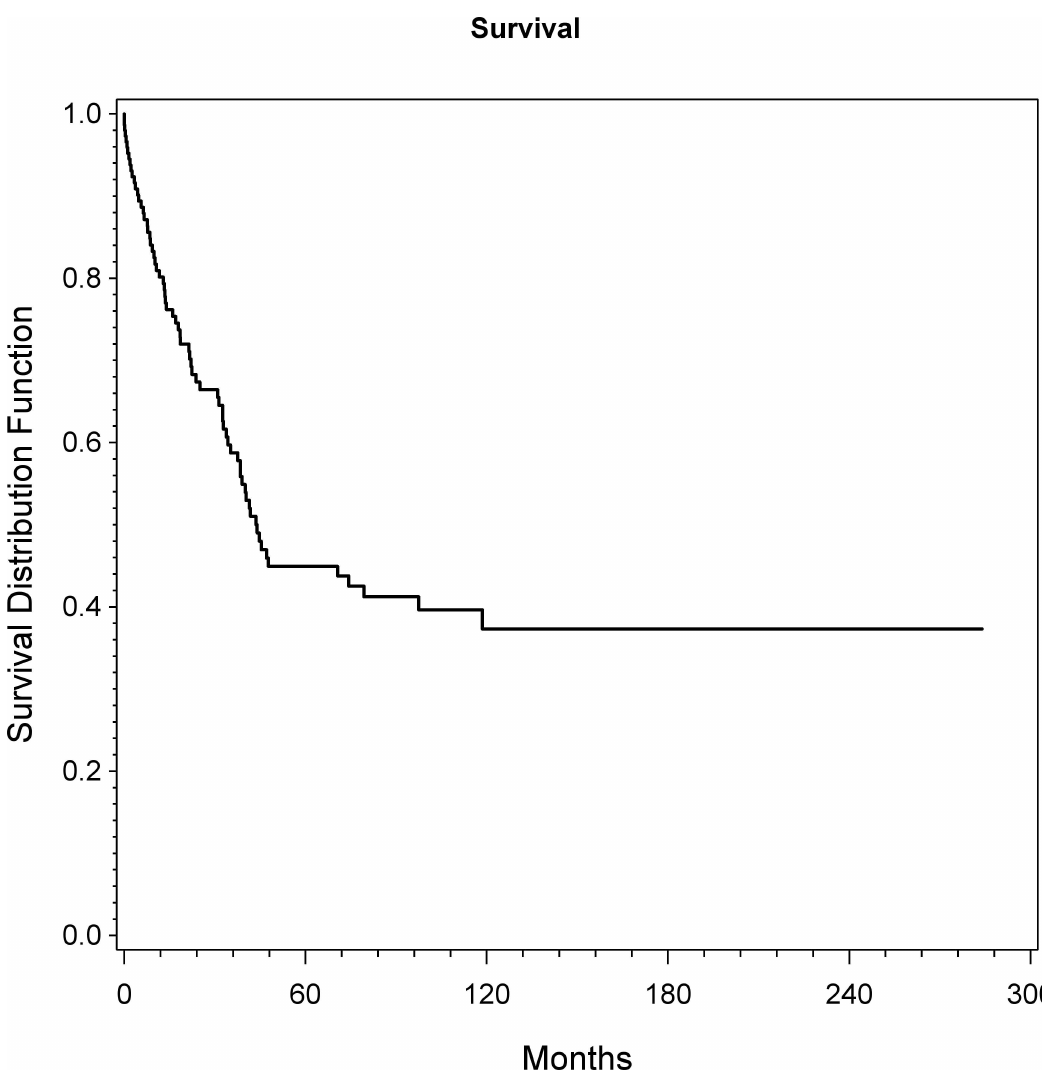
Fig 1. Overall survival of all patients as assessed by KM